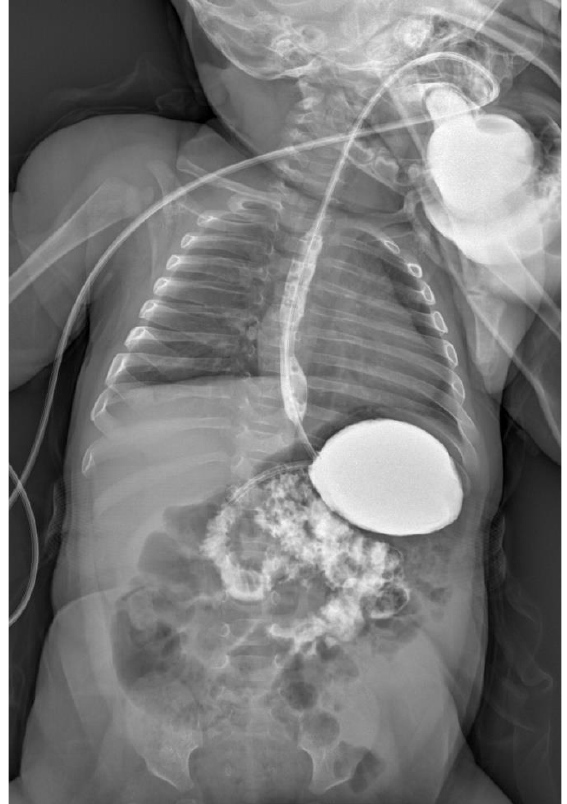
Figure 2. Upper GI contrast study: 6 months old girl presenting with ongoing vomiting and failure to thrive. The contrast study shows an enlarged stomach horizontally orientated, the antrum cranially displaced to the pylorus as per organo-axial gastric volvulus.